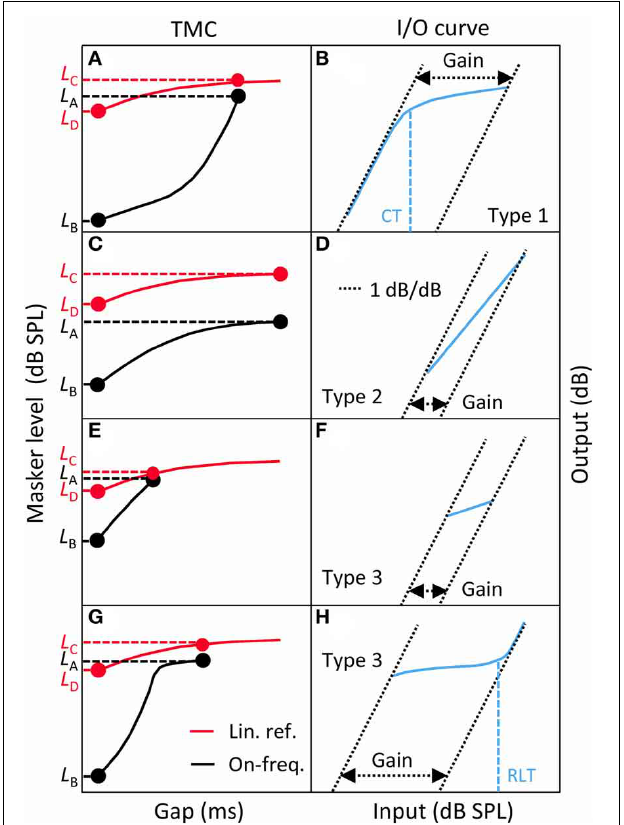
FIGURE 5 | A taxonomy of I/O curves (blue line, right panels) and their corresponding TMCs (left panels). Left: linear-reference (red curves) and on-frequency (black curves) TMCs. Right: corresponding, inferred I/O curves. (A,B) for Type 1 I/O curves. (C,D) for Type 2 I/O curves. (E,F) for Type 3 I/O curves with little residual gain. (G,H) for Type 3 I/O curves with large residual gain. CT, compression threshold; RLT, return-to-linearity threshold. See main text for details.